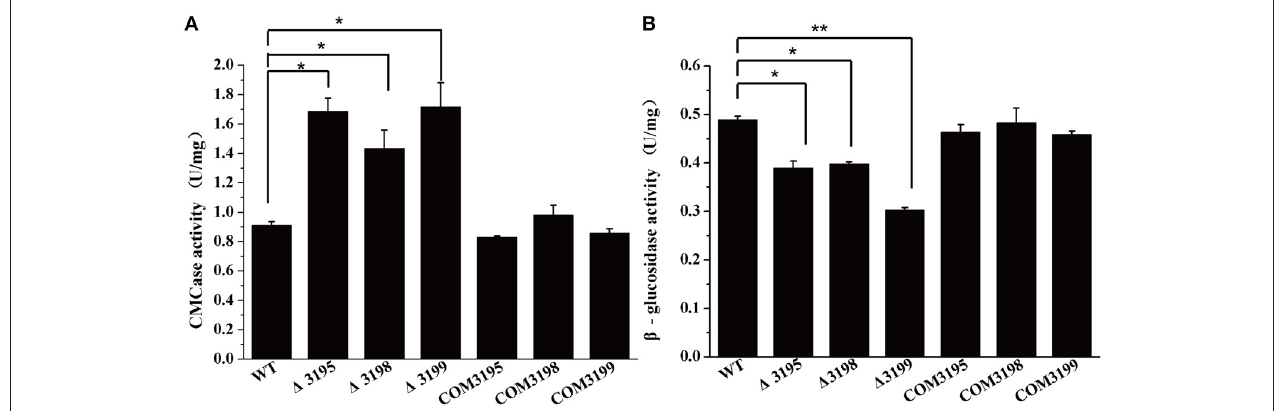
FIGURE 3 | Endoglucanase (A) and β -glucosidase (B) activity of the intact cells of WT, t2s mutant strains, and t2s complemented strains. Statistical analysis was performed using the student’s t -test analysis. Significant differences ( T -test * P < 0.05, ** P < 0.01) in the enzymatic activities were detected between WT and t2s mutant strains. Values in this figure are the mean of three to five biological replicates. Error bars are the SD from these replicates.